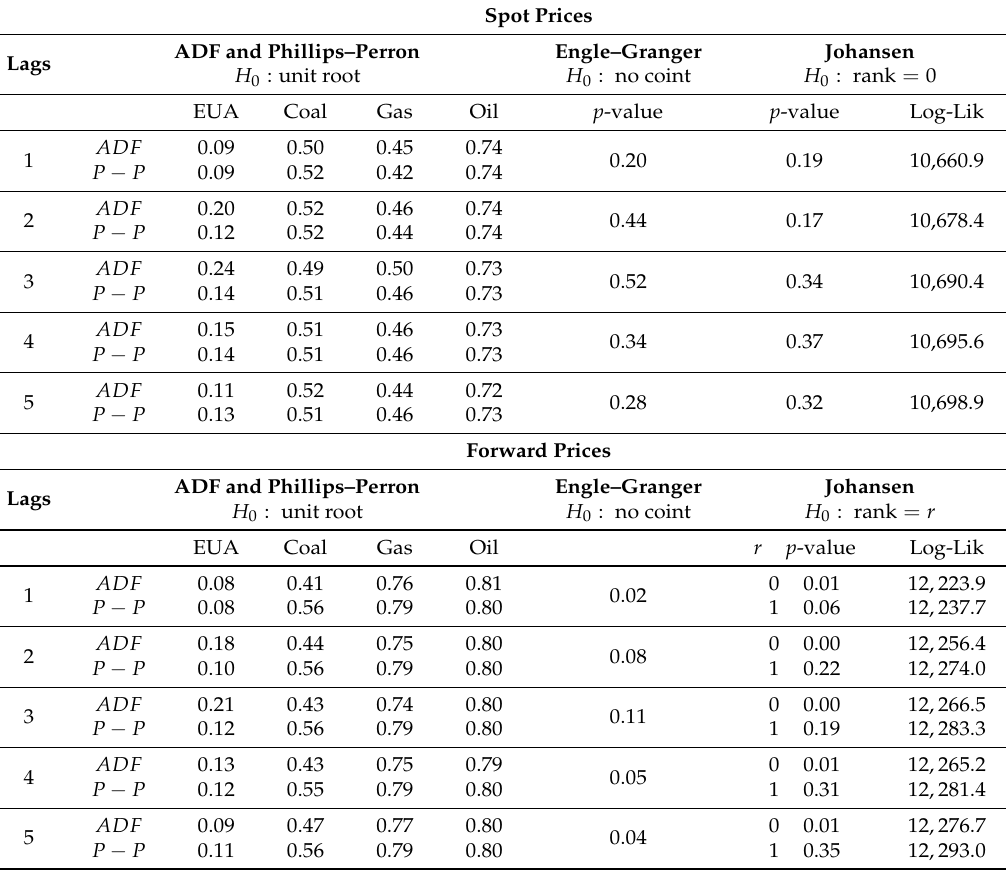
Table 1. (MacKinnon) p -values corresponding to Augmented Dickey–Fuller (ADF) and Phillips–Perron (P-P) unit root tests (left columns) and corresponding to Engle–Granger and Johansen cointegration tests (right columns) for the daily spot (top panel) and forward series (bottom panel). Spot Prices